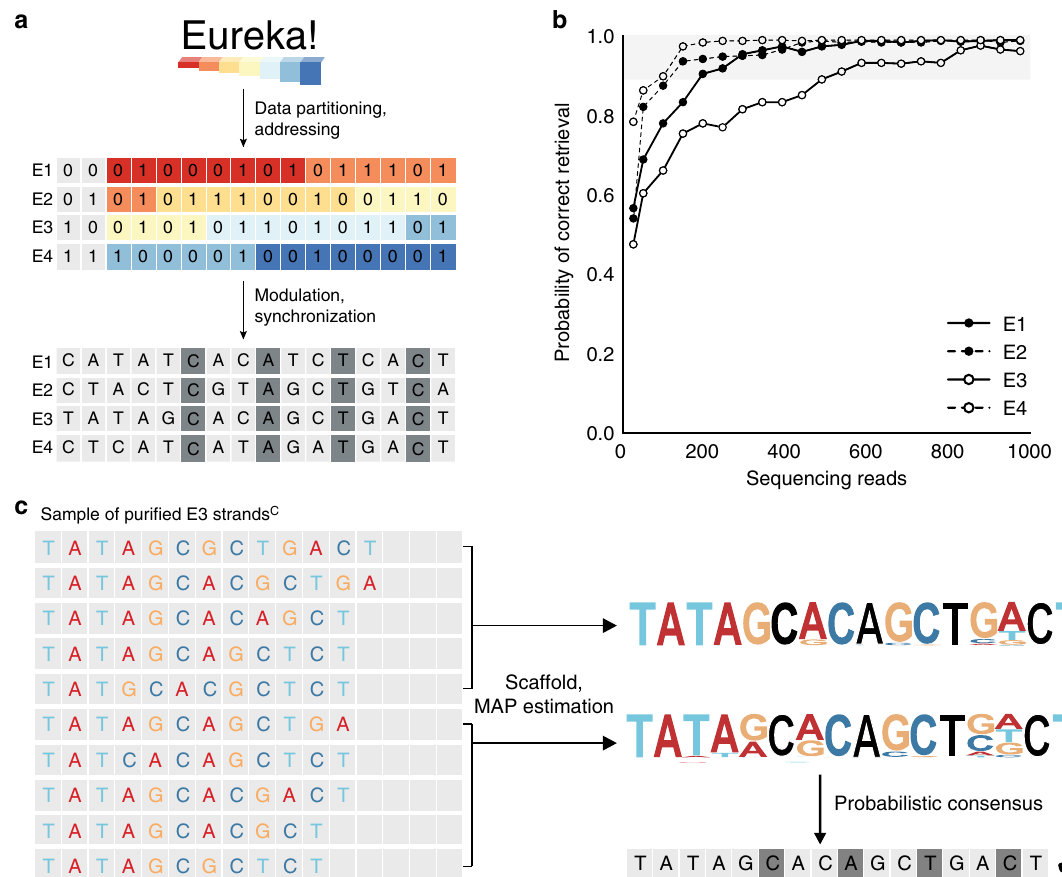
Fig. 4 Coded strand architecture for robust information storage. a The message “ Eureka! ” was encoded and partitioned into four template sequences, E1 – E4. Each sequence stores a 2-bit address and 14 bits of data. These bits are mapped to a template sequence of 16 nucleotides, which includes four synchronization nucleotides (dark gray). Synthesis was performed with initiators tethered to beads and sequencing performed on the Illumina platform. b Retrieving information from E1 to E4. Synthesized strands R were sequenced using the Illumina sequencing-by-synthesis (SBS) platform and puri fi ed in silico based on raw length of 32 – 48 nucleotides (Methods). The decoding accuracy for each sequence is de fi ned as the probability of 100% correct data retrieval for a given number of reads, estimated over 500 decoding trials. Each trial is based on a randomly drawn set of puri fi ed strand C variants. A 90% decoding accuracy (gray band) is considered suf fi cient for robust data retrieval, and this accuracy could be further reinforced by other codec modules. c Decoding of E3. A set of 10 DNA strands C is decoded as two sets of fi ve strands C . The decoder uses MAP estimation and a scaffold to determine the probability for each of the four nucleotides at every position. The decoded sequence is a probabilistic consensus of the reconstructed sequences from MAP estimation and successfully retrieves the data stored in E3. Source data for b is provided in the Source Data fi le